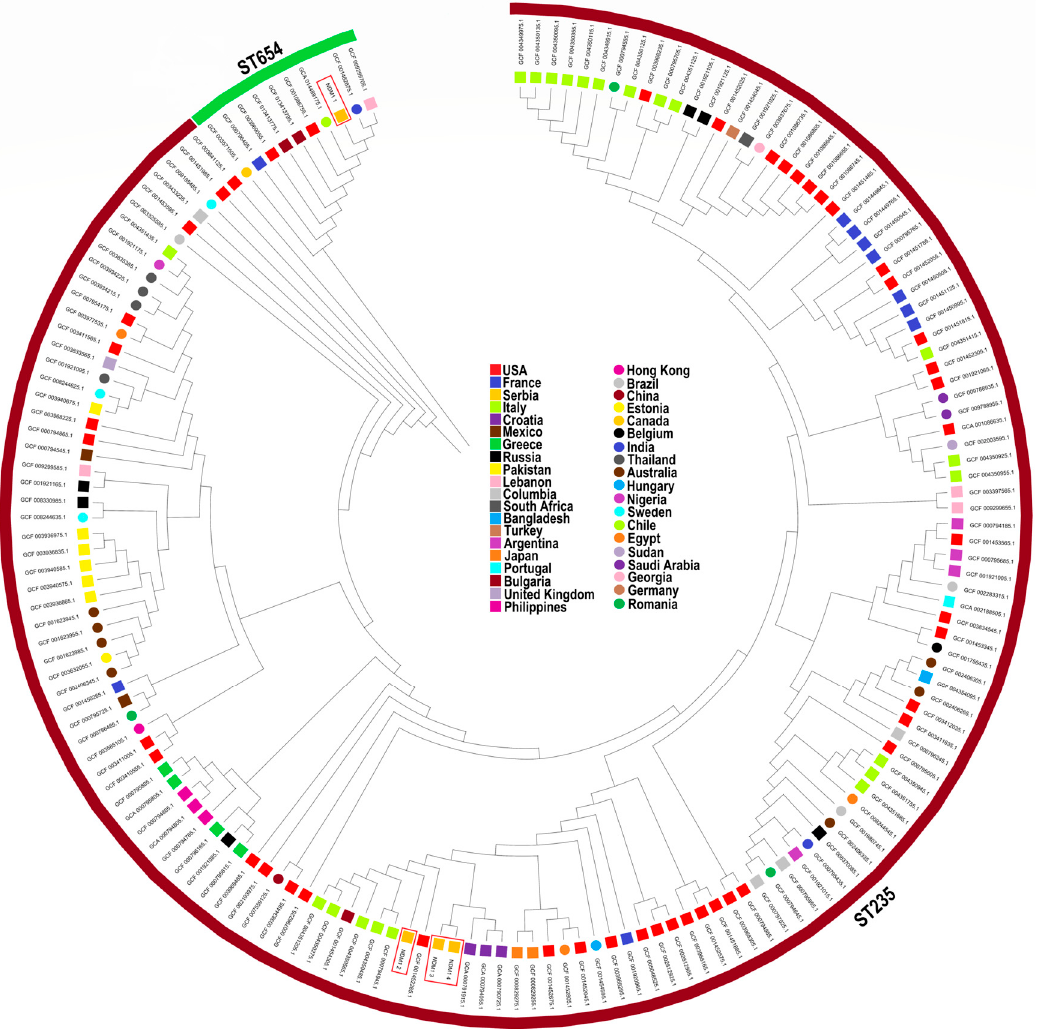
Figure 4. Phylogenetic tree constructed by calling SNPs from core gene alignment of the 165 high- risk clones of Pseudomonas aeruginosa (ST235 and ST654) using the neighbor-joining method with 1000 bootstraps. The different countries can be distinguished by different shapes and color codes displayed in the figure legend; the fragments with different colors in the outer ring represent corre- sponding sequence types (STs), as shown.